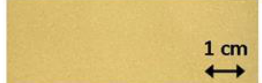
Figure 1. Photo of the studied PU foam